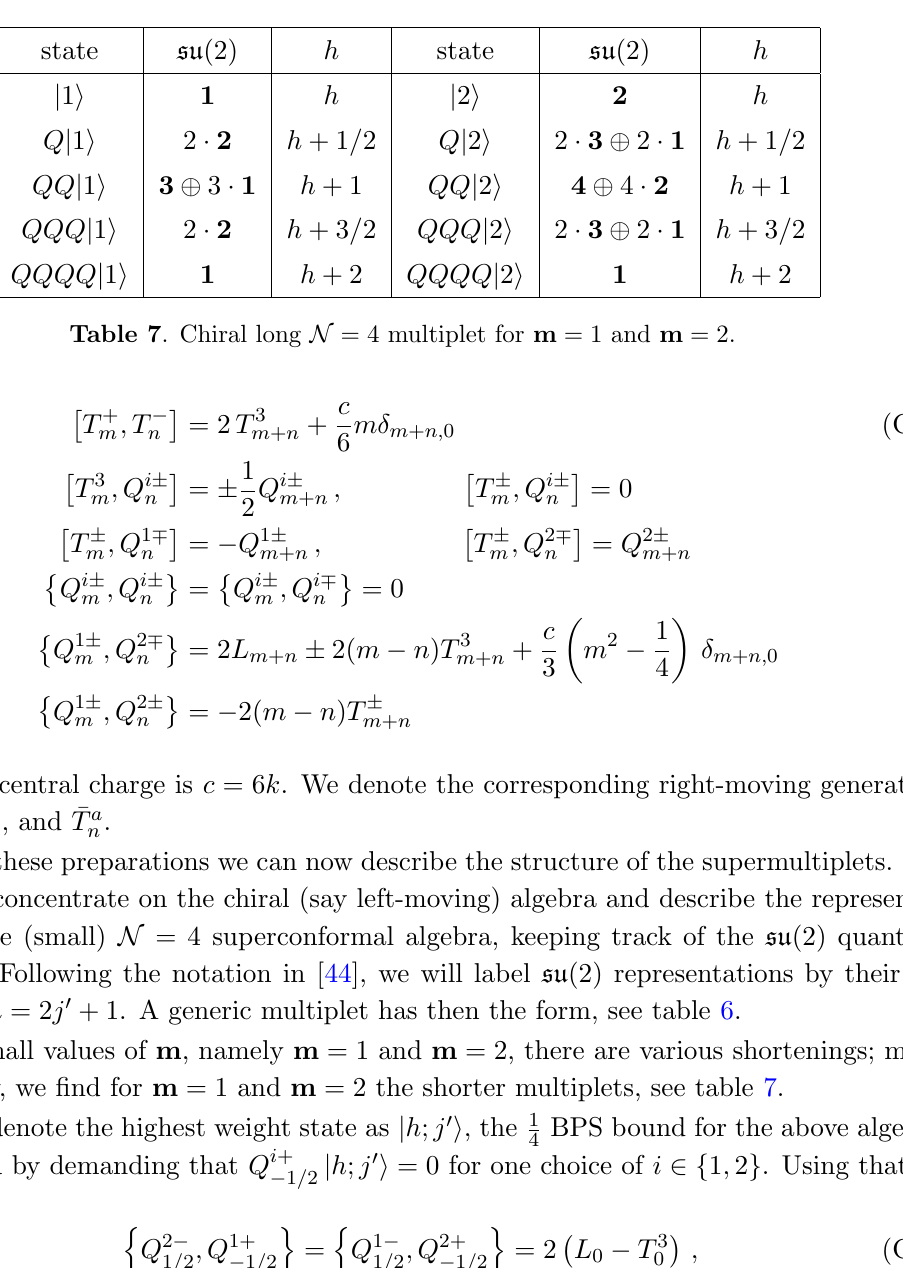
Table 6 . Chiral long N = 4 multiplet.